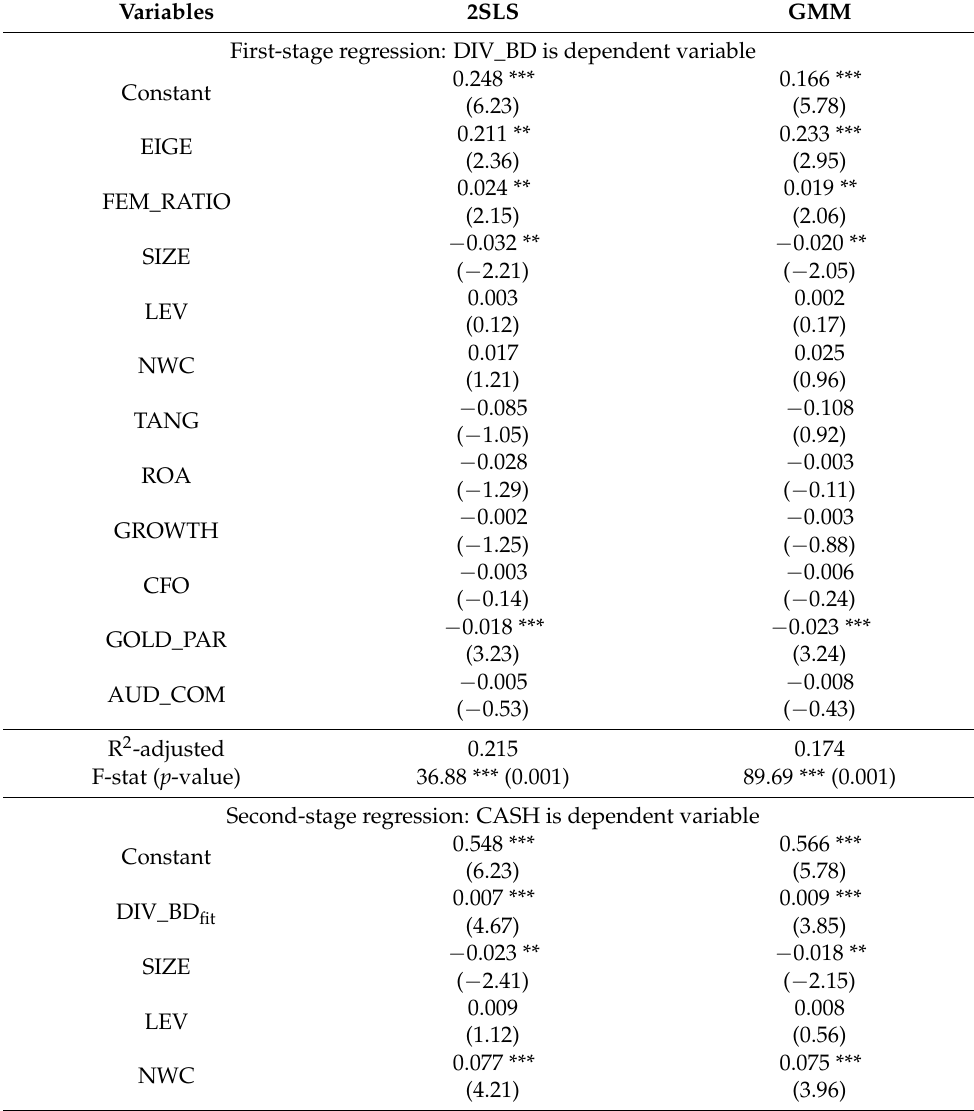
Table 7. Endogeneity controls using 2SLS and GMM